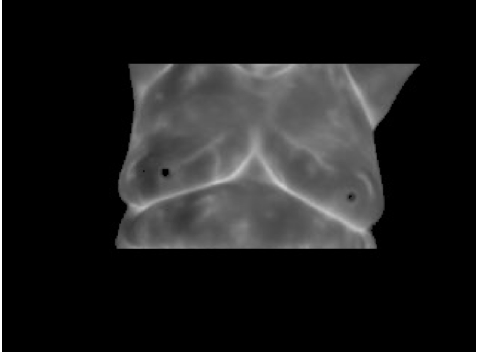
Figure 8. Thermogram acquired at a 1.2-m distance.